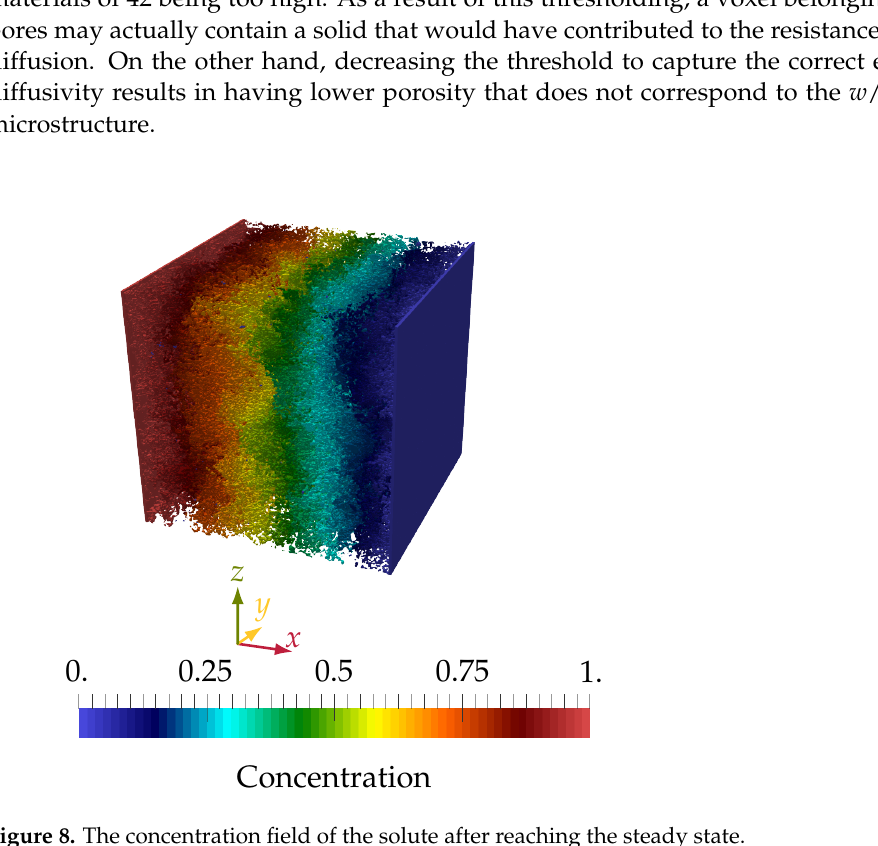
Figure 8. The concentration field of the solute after reaching the steady